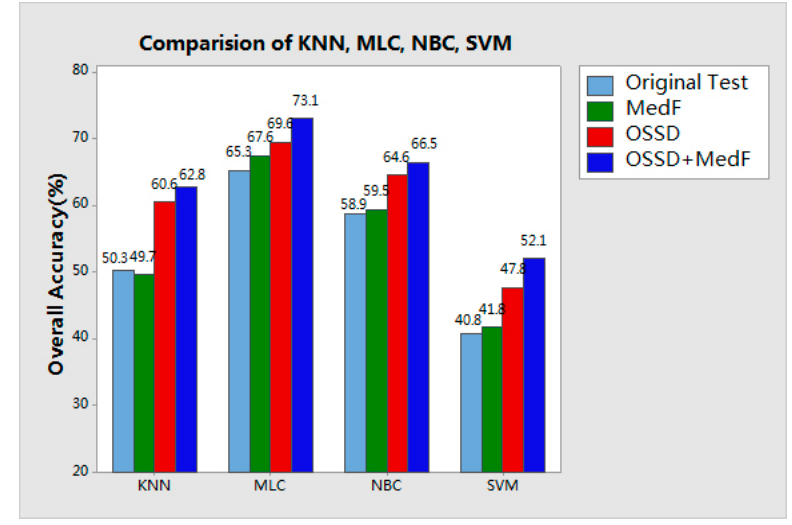
Figure 10. Pavia University image accuracy comparisons of OA (%) based on different classification methods and supervised classifiers.